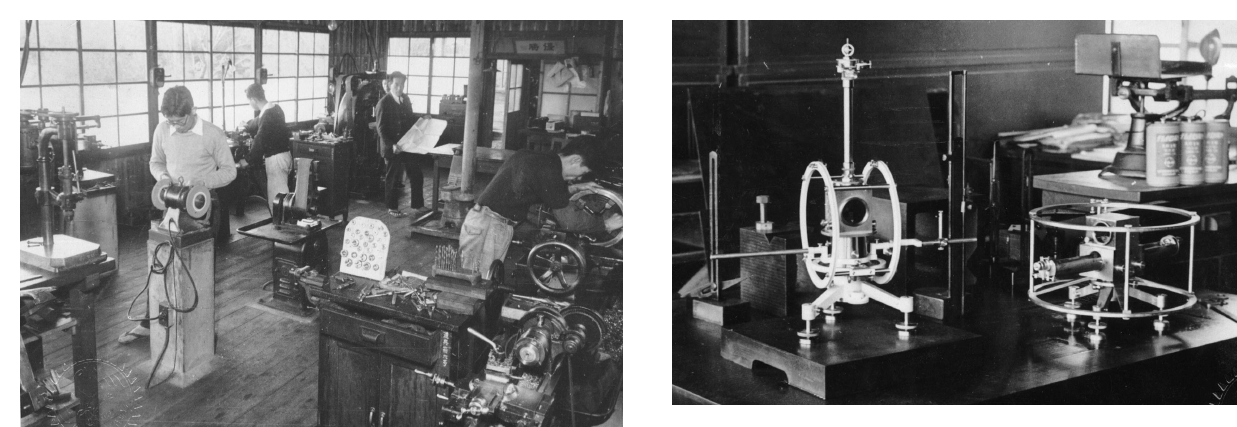
Figure 19. The craft room at Kakioka Magnetic Observatory (photo supplied by Kakioka Magnetic Observatory).